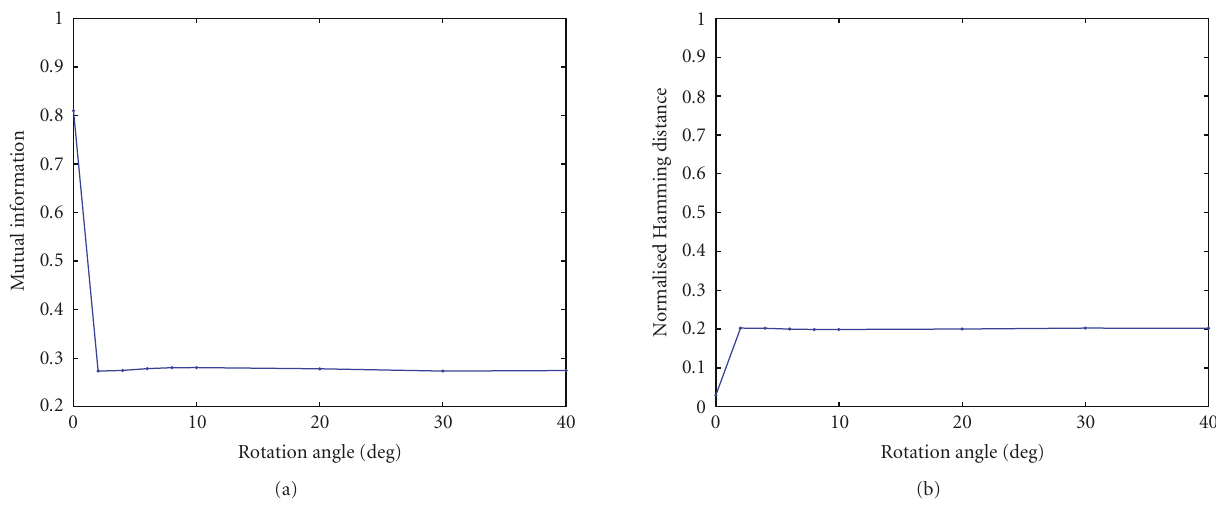
Figure 15: Detector response to rotation attack: (a) mutual information; (b) normalized Hamming distance.